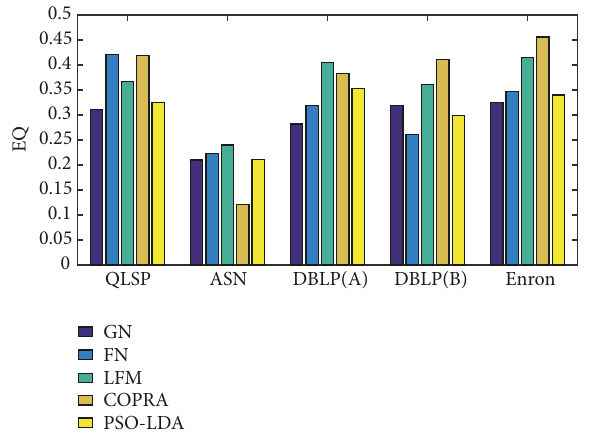
Figure 11: The histogram of 𝐸𝑄 with various classical